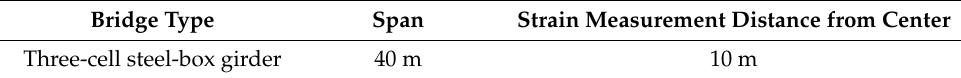
Figure 10. Experimental setup showing ( a ) the steel-box girder bridge and ( b ) its sectional and ( c ) lateral views. Table 4. Configurations for experimental validation on the Jojungchun Bridge.